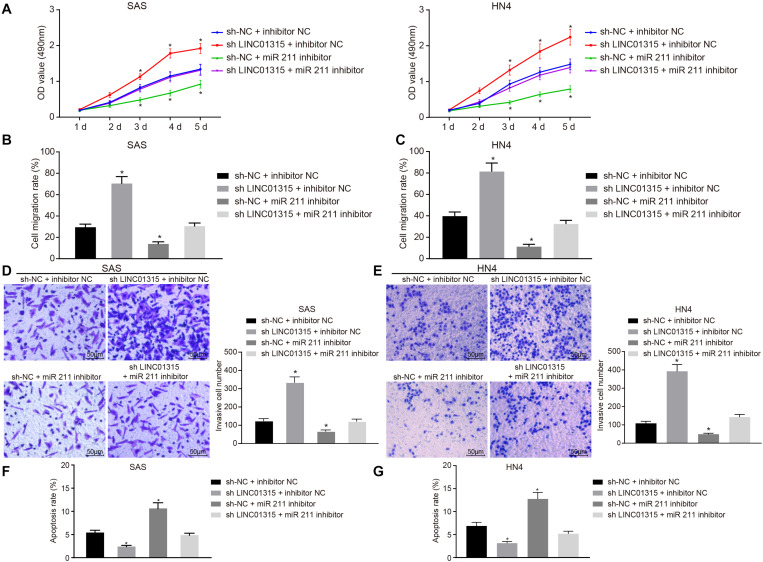
LINC01315 binds to miR-211 to hinder the progression of OSCC. SAS and HN6 cells were transfected with sh-LINC01315/sh-NC and miR-211 inhibitor/inhibitor NC. (A) Cell viability in SAS and HN6 cells assessed by MTT assay; (B) SAS cell migration ability measured using scratch test; (C) HN6 cell migration ability measured using scratch test; (D) SAS cell invasion ability evaluated using the Transwell assay; (E) HN6 cell invasion ability evaluated using the Transwell assay; (F) SAS cell apoptosis assessed by flow cytometry. (G) HN6 cell apoptosis assessed by flow cytometry. The data were expressed as mean ± standard deviation and data among multiple groups were analyzed using one-way ANOVA. *p < 0.05 vs. the sh-NC + inhibitor NC group. The experiment was repeated three times independently.